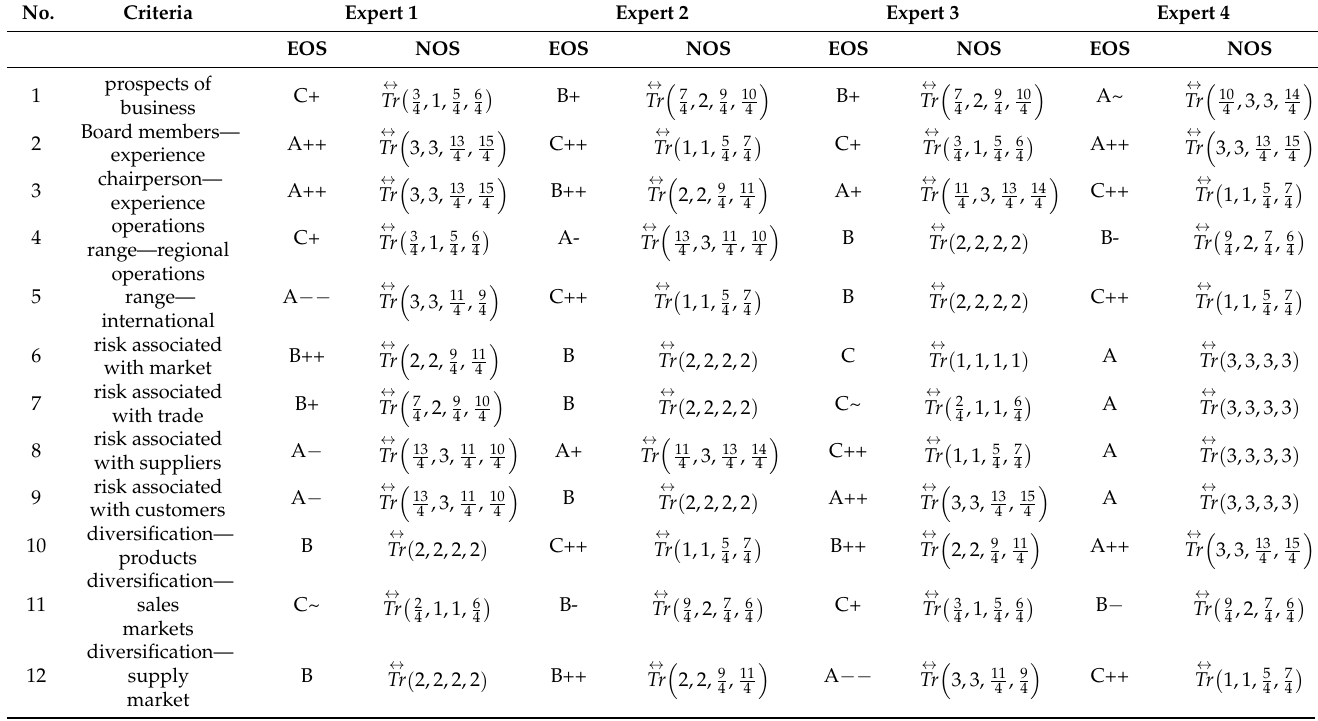
Table 2. Experts’ evaluation of attributes of a construction